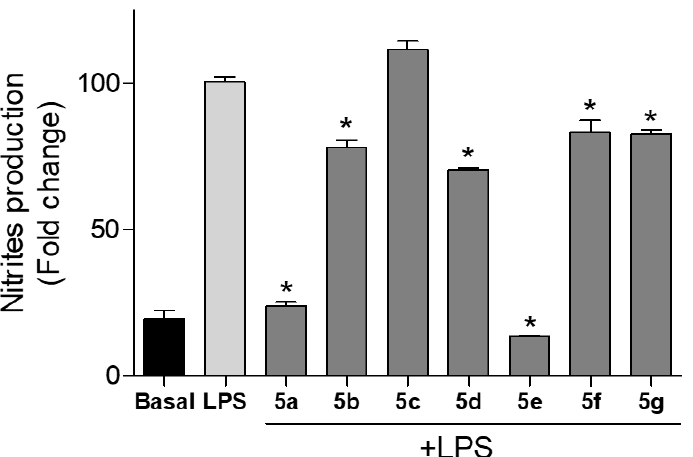
Figure 6. Effects of compounds 5a – 5g on NO release in macrophage cells. RAW 264.7 cells were cotreated with the compound at 10 µ M and 200 ng/mL LPS for 24 h. Nitrite accumulation in the culture media was measured using the Griess reagent. Results were expressed as a fold change relative to the LPS condition and mean ± SD (n ≥ 3 independent experiments performed in duplicate). Significant differences were determined by one-way ANOVA followed by Bonferroni t test; * p ≤ 0.05 vs. LPS.